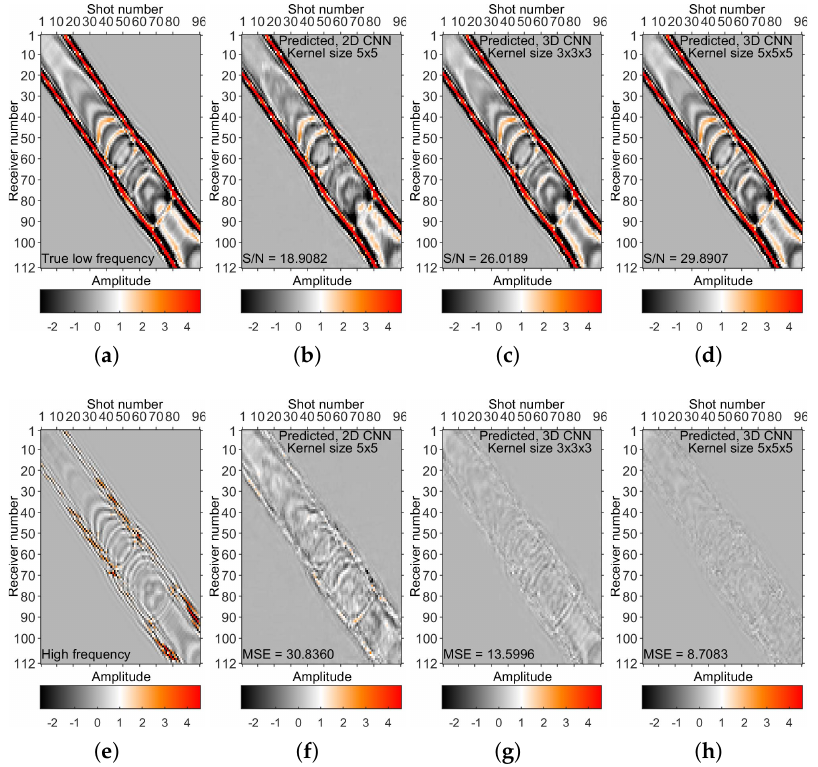
Figure 14. A time slice view at 1.2121 s of the 3D data volumes shown in Figure 11. ( a ) The time slice of the true LF data (<5 Hz) of Figure 11c. ( b ) The time slice of predicted LF data by 2D CNN of Figure 11d. ( c ) The time slice of predicted LF data by 3D CNN (kernel size = 3 × 3 × 3) of Figure 11e. ( d ) The time slice of predicted LF data by 3D CNN (kernel size = 5 × 5 × 5) of Figure 11f. ( e ) The time slice of the HF data ( (cid:62) 5 Hz) of Figure 11b. Panels ( f – h ) show the LFR residuals for the results in panels ( b – d ),